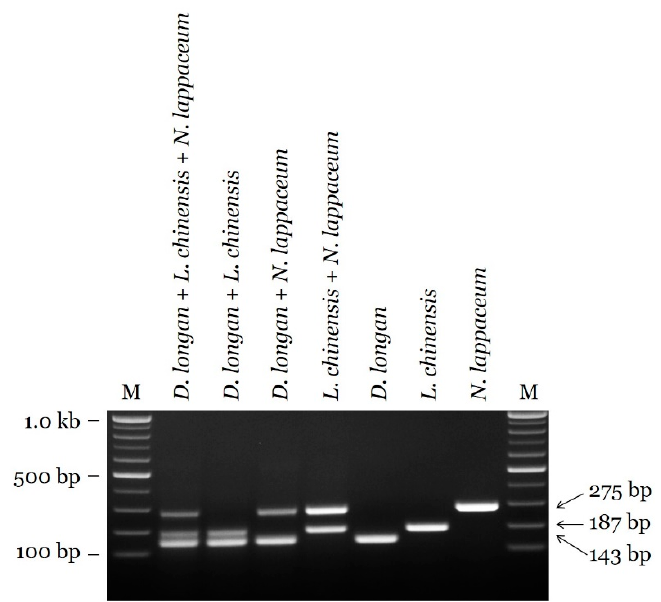
Figure 3. Sensitivity of singleplex PCR assays using the species-specific primer sets. M: 100 bp DNA size marker (100–1000 bp), NTC: no template control. Arrowheads indicate the amplified fragment sizes. White asterisks indicate the limit of detection.